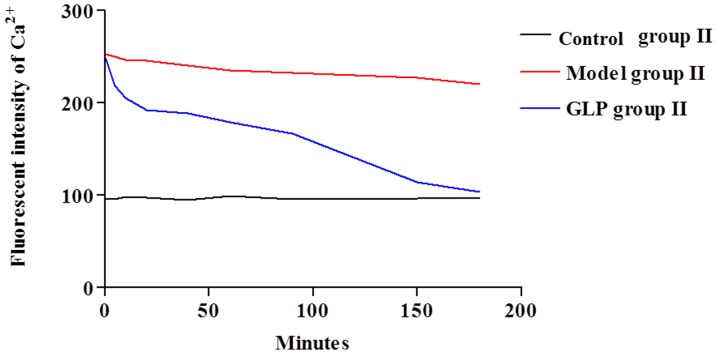
Changes in fluorescence intensity of Ca2+ in neurons during the treatment, n  =  4, thirty neurons were observed in each replicates.There is no change in fluorescence intensity of Ca2+ in neurons in the Control group II during a 3 hour period. Fluorescence intensity of Ca2+ in neurons was highest in neurons cultured in Mg2+ ion free medium for 3 hours prior to replacement with normal maintaining medium i.e. Model group II; there is no significant decrease (P>0.05) between the zero time point (0 hour) and 3 hours following the normal medium replacement. However, following GLP treatment, there is a gradual decrease in Fluorescence intensity of Ca2+ in neurons, with levels almost returning to normal after 3 hours. Tukey’s test following one way ANOVA was used to perform statistical analysis.